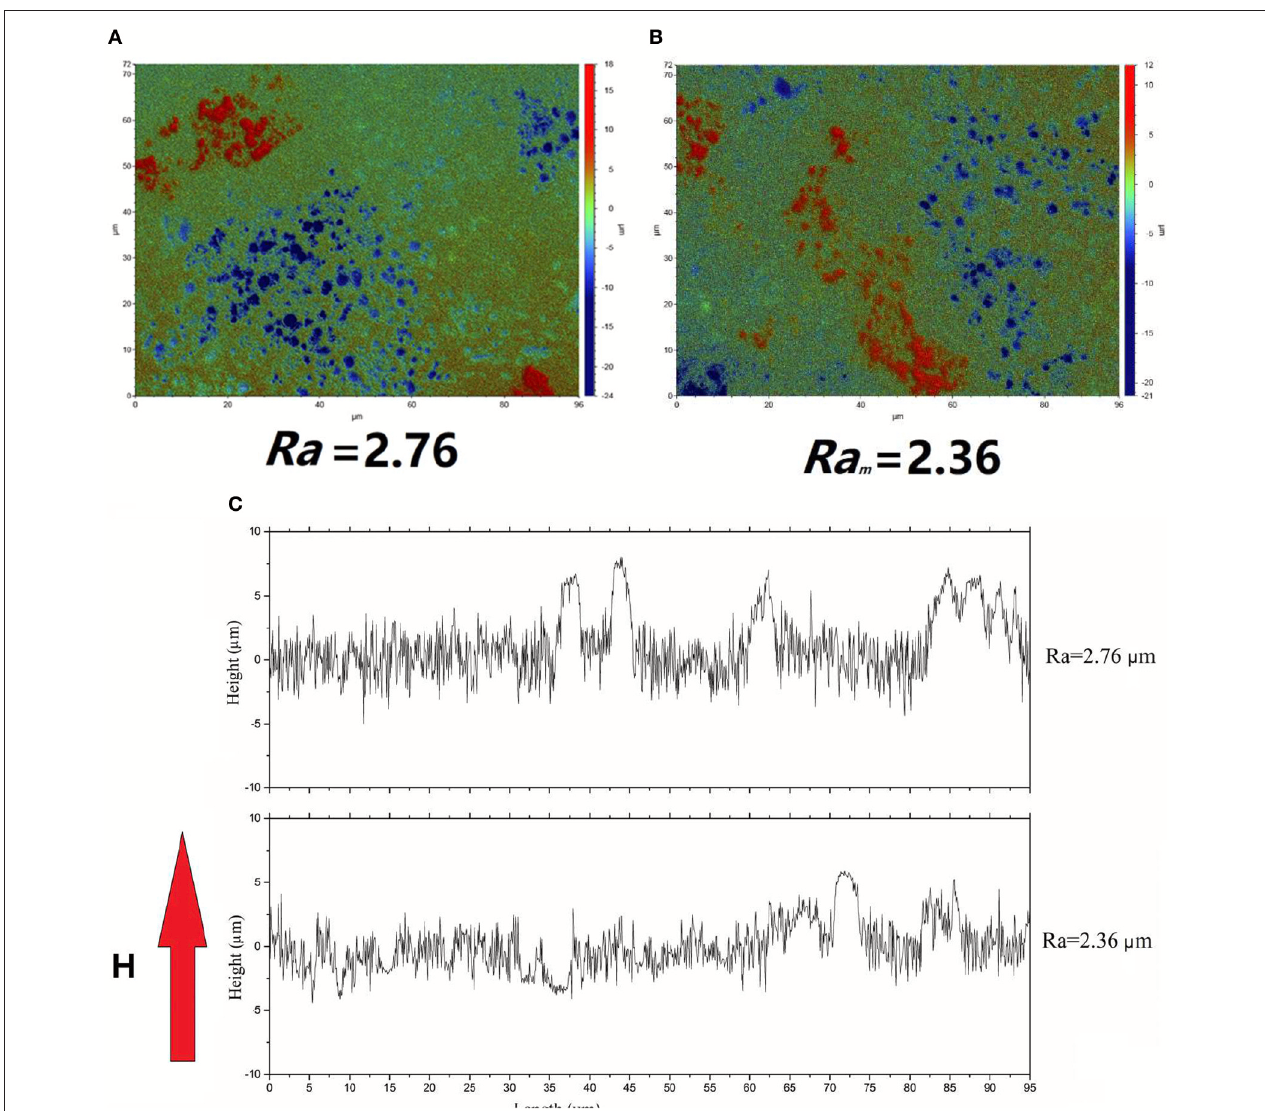
FIGURE 5 | White light interferometer test results of a typical MRE (10% particle volume fraction, generated by iron mold) (A) the initial surface contour, the roughness is 2.76 µ m (B) the surface contour under a magnetic field of 450 mT, the roughness is 2.36 µ m (C) the 2-demension profiles of MRE.